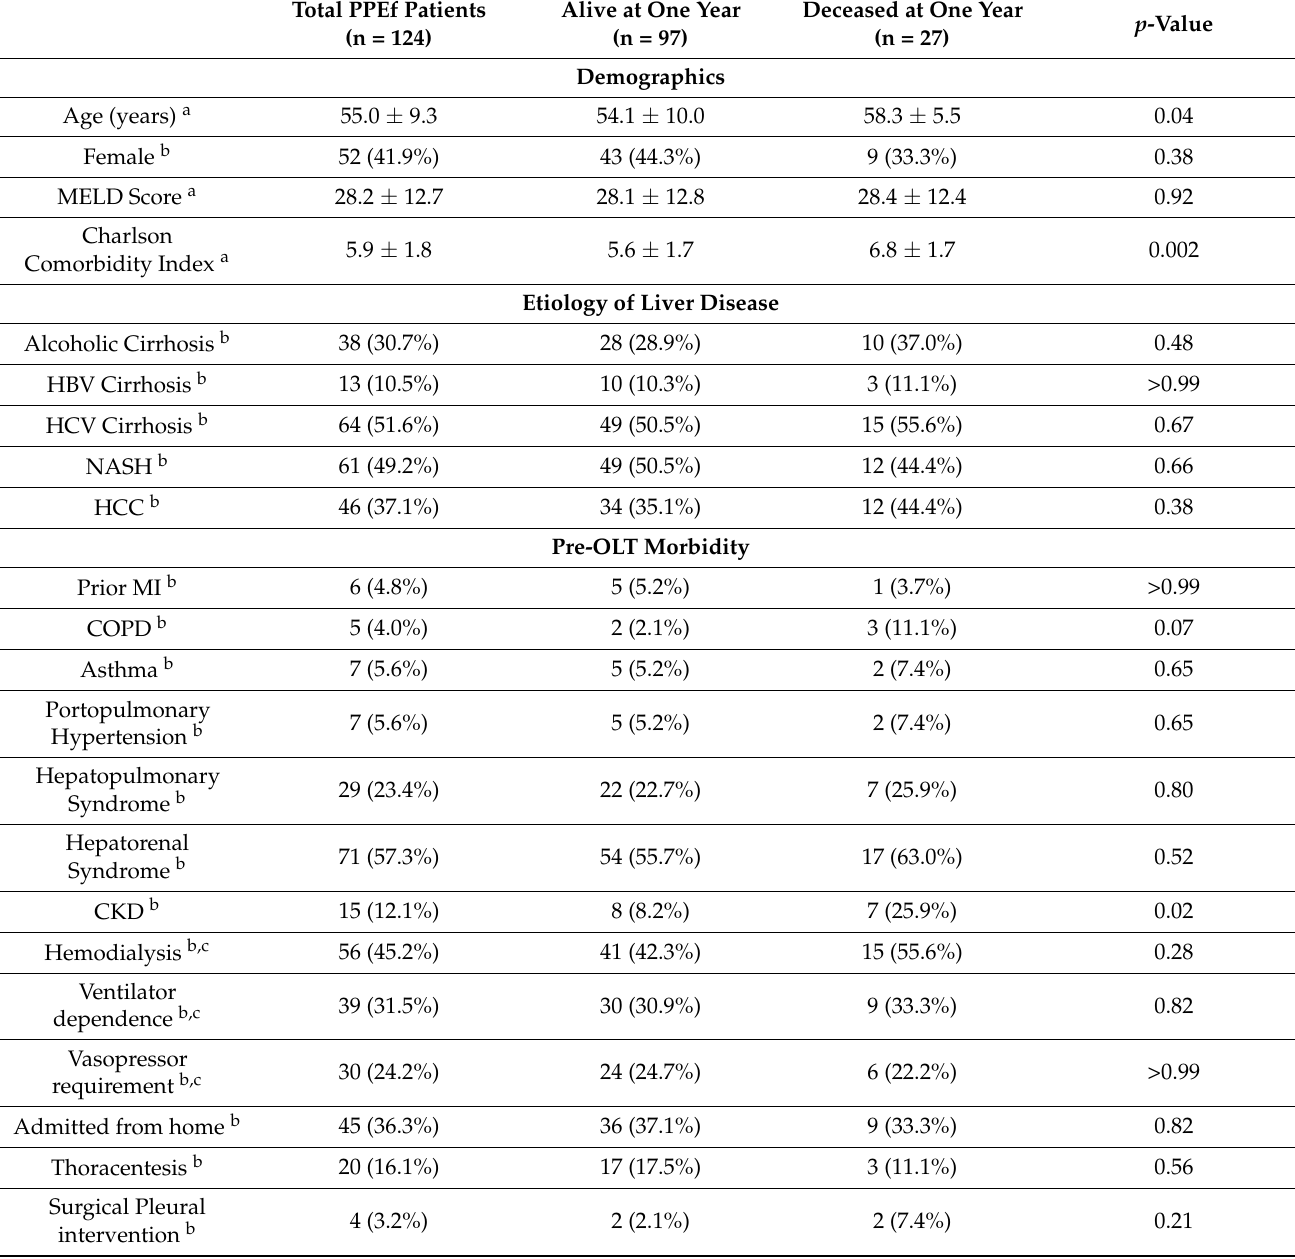
Table 1. Clinical characteristics and one-year mortality risk factors for persistent pleural effusion